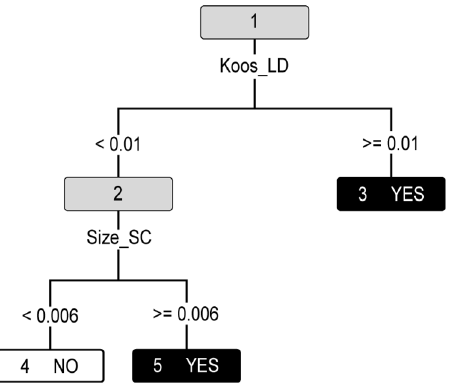
Figure 6. PDA decision tree. A decision tree for PDA EXP FIN variables, applied on PDA data.